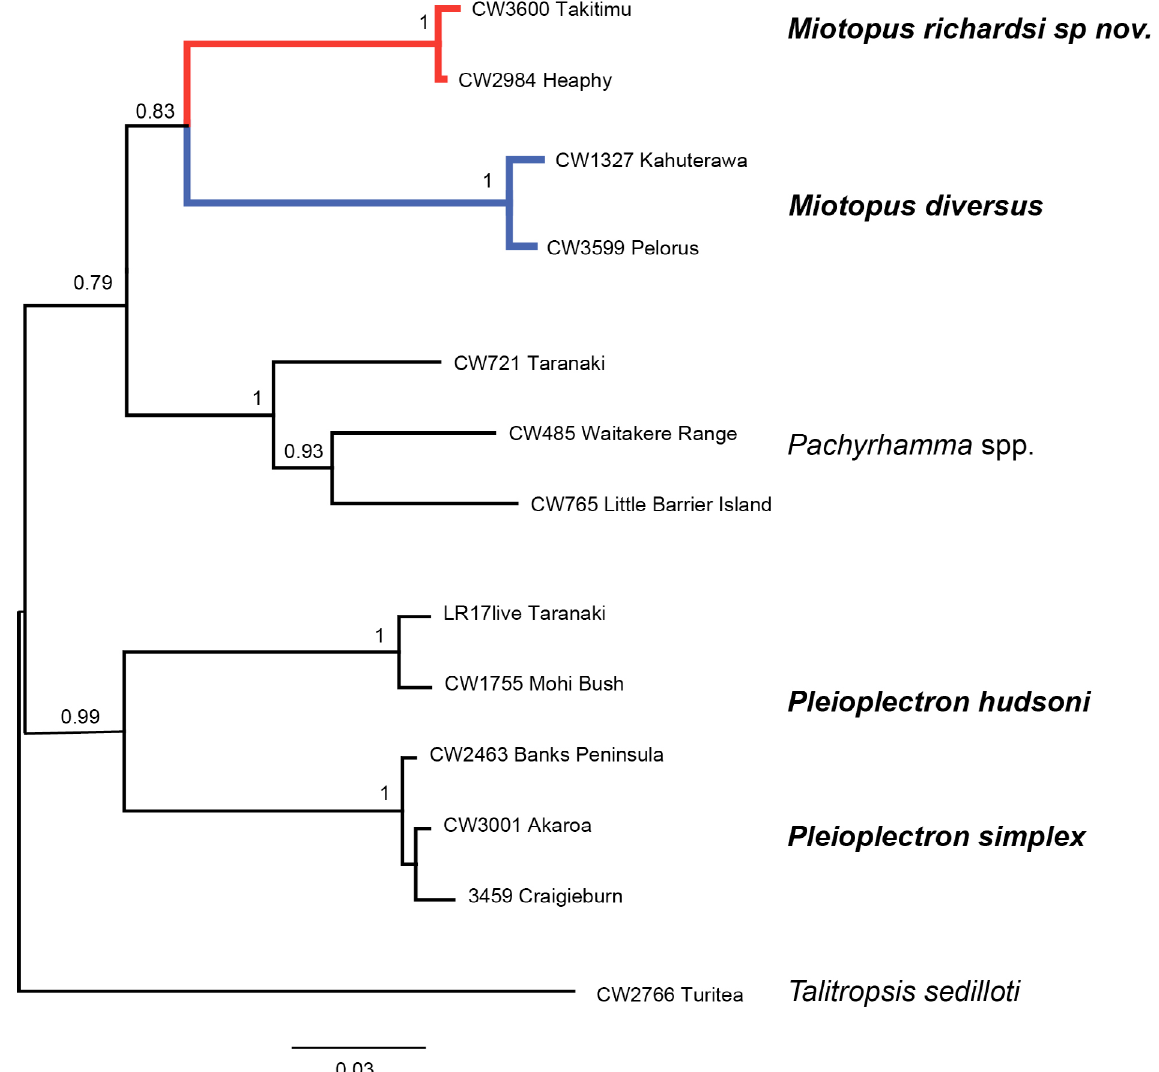
Fig. 3. Phylogenetic relationship of Pleioplectron hutton, 1896 and Miotopus hutton, 1898 inferred from Bayesian Inference of 1435bp mtDNA COI sequence alignment with four 4 × 10 6 MCMC chains, sampling every 2 × 10 3